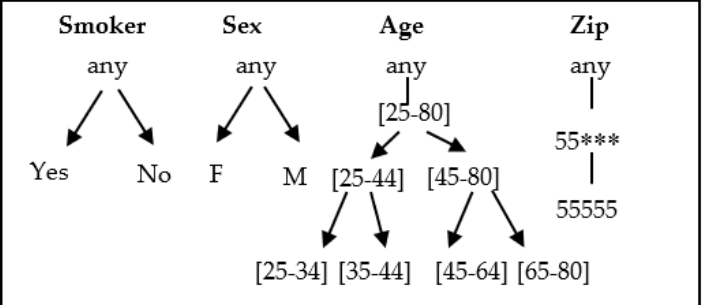
Figure 7. Taxonomy Trees.